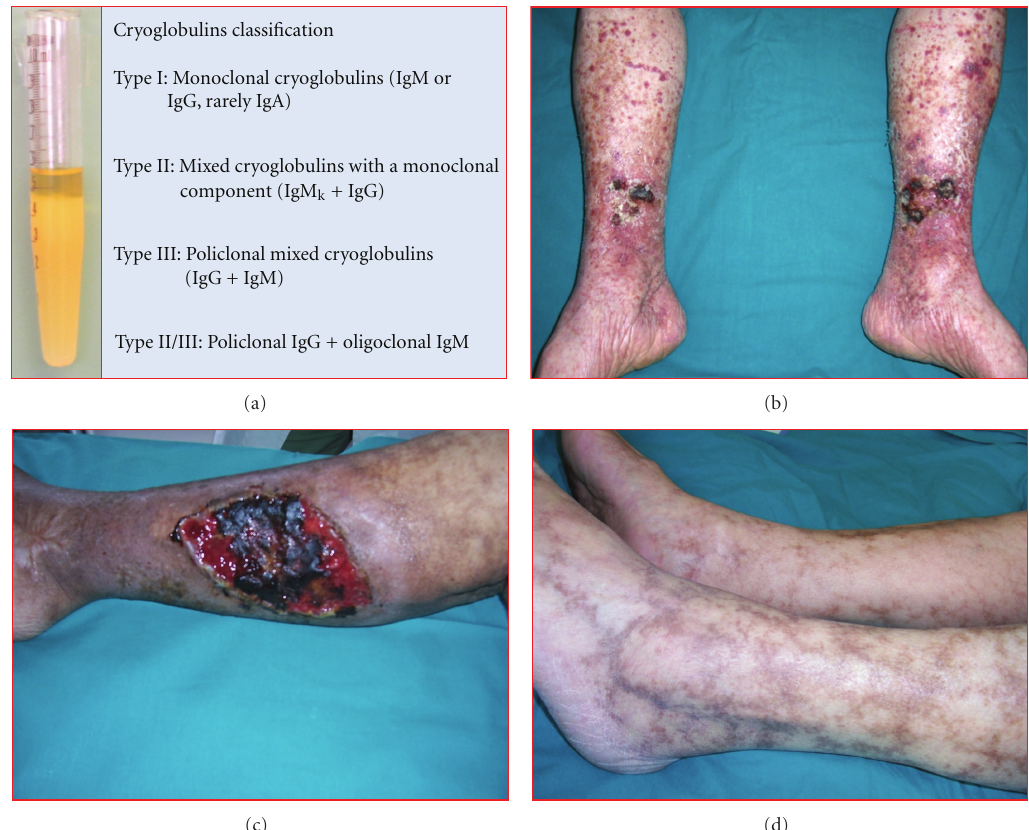
Figure 2: Clinical aspects of cryoglobulinemia. (a) Cryoglobulins classification; (b) lower limbs purpuric manifestations; (c) cutaneous ulcers; (d) livedo